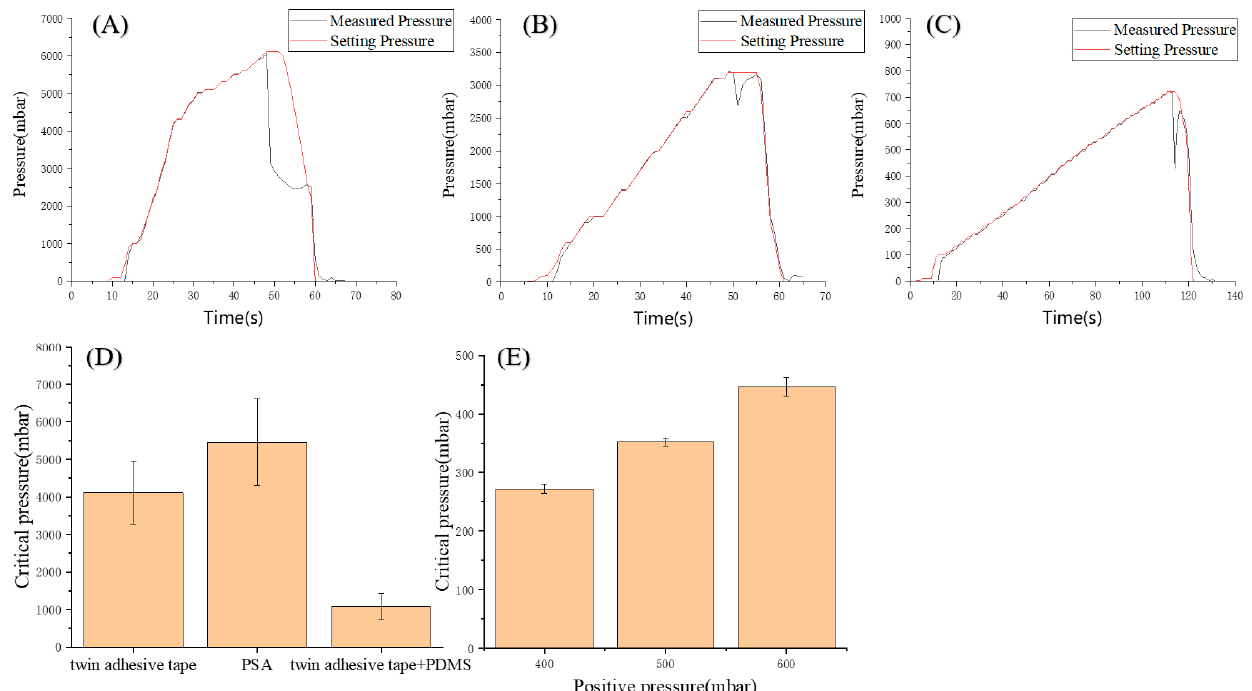
Figure 3. Typical bonding test curves of PSA ( A ), twin adhesive tape ( B ) and PDMS ( C ) with the chip. ( D ) The critical pressure that the different bonding can withstand. ( E ) The critical pressure that the microvalve can withstand at a given positive pressure. (n = 3).